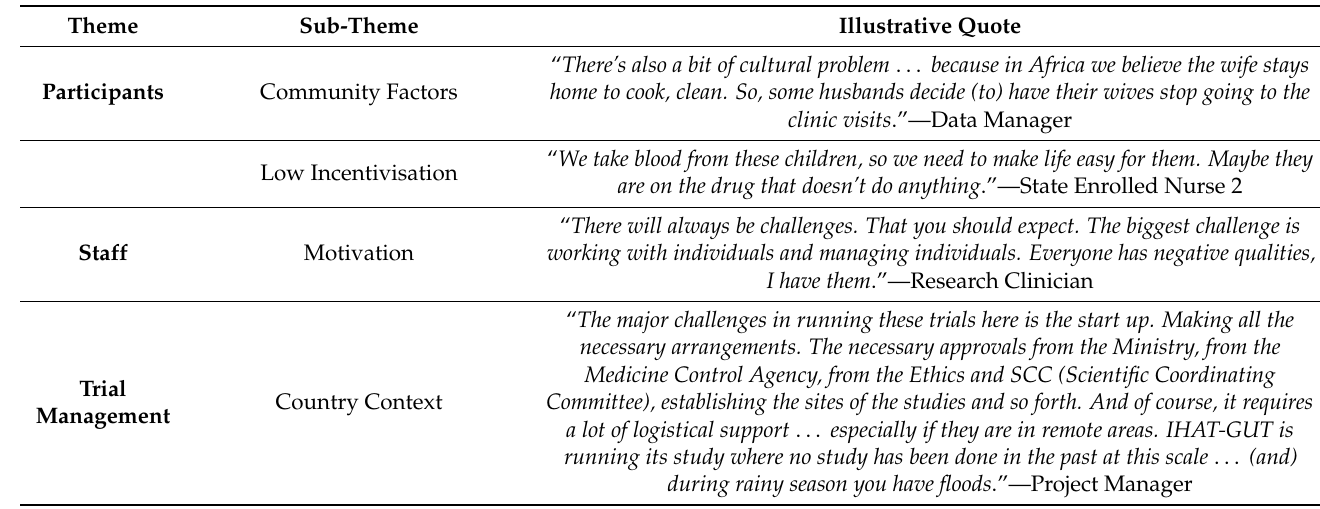
Figure 2. Graphical illustration of themes and sub-themes of the barriers. Table 3. Illustrative quotes for each sub-theme of the